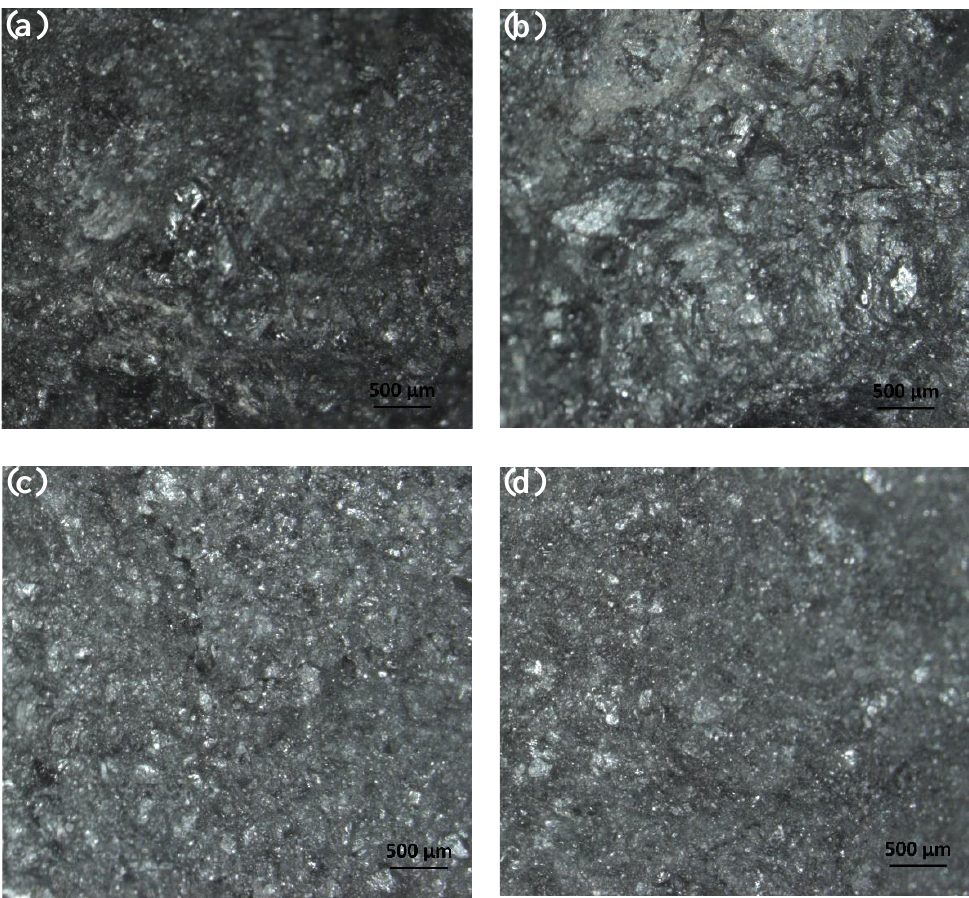
Figure 12. Sectional view of briquettes with different particle sizes: ( a ) group A, (b ) group B, ( c ) group C and ( d ) group D.